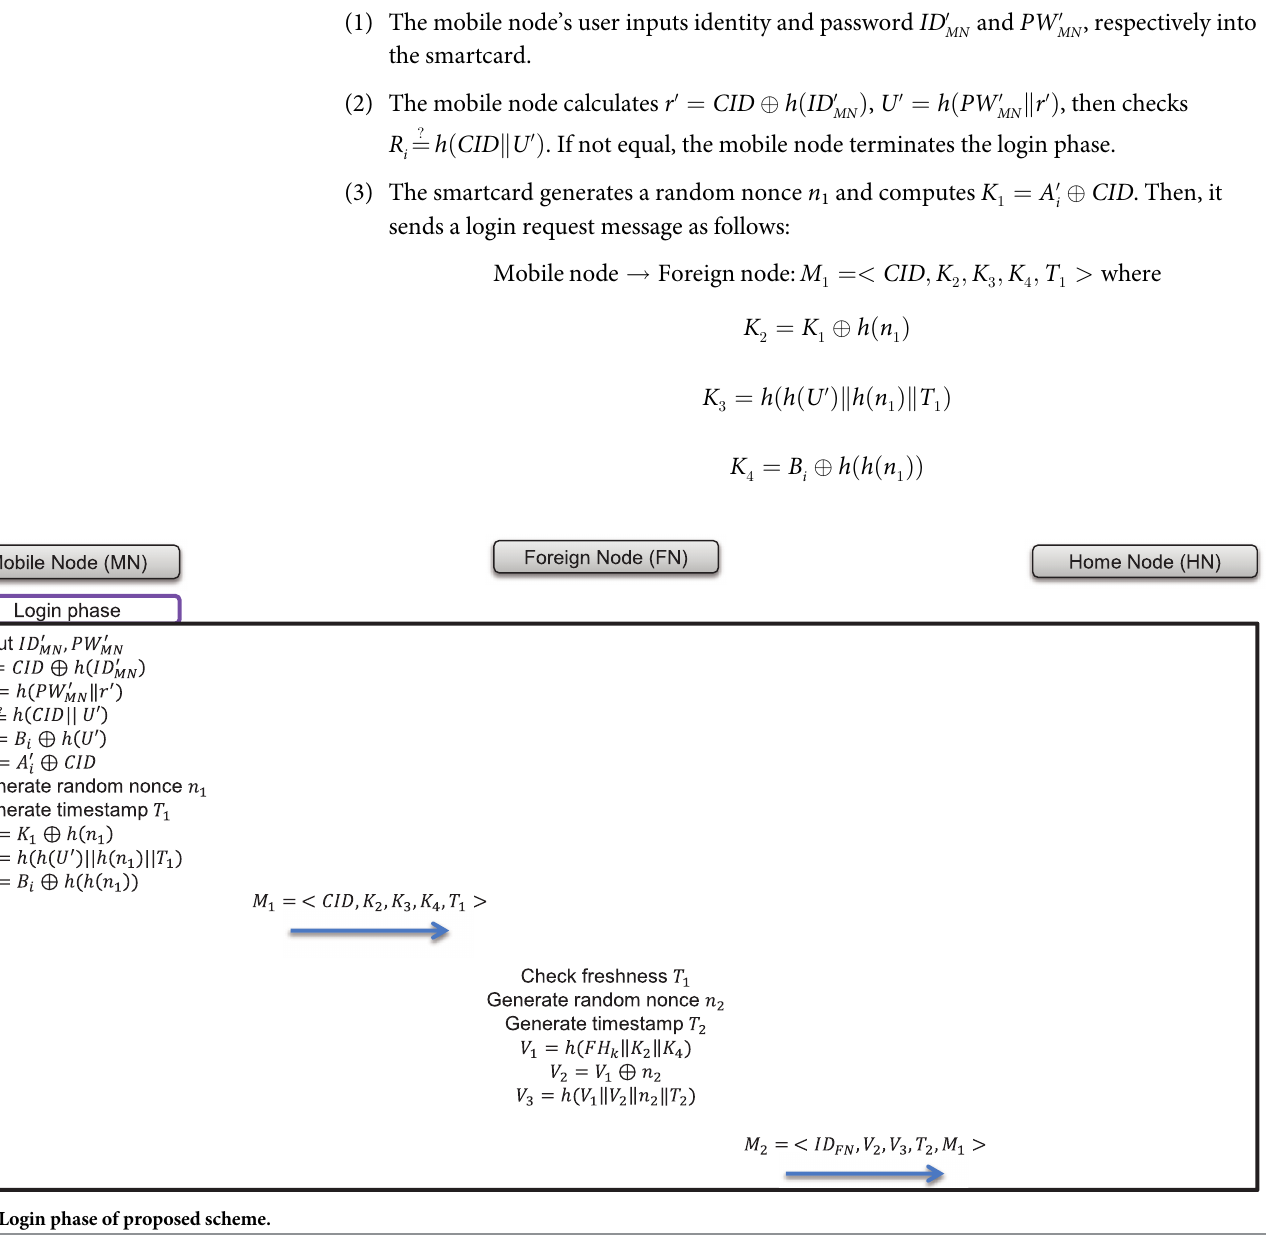
PLOS ONE | https://doi.org/10.1371/journal.pone.0247441 February 26,